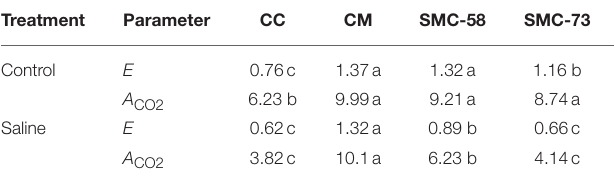
Values are the mean of six plants (n = 6). Different letters in each line indicate significant differences for P ≤ 0.05 at Duncan’s multiple range test. Plants were cultivated in a greenhouse for 20 days, either in saline (40mM NaCl) or control